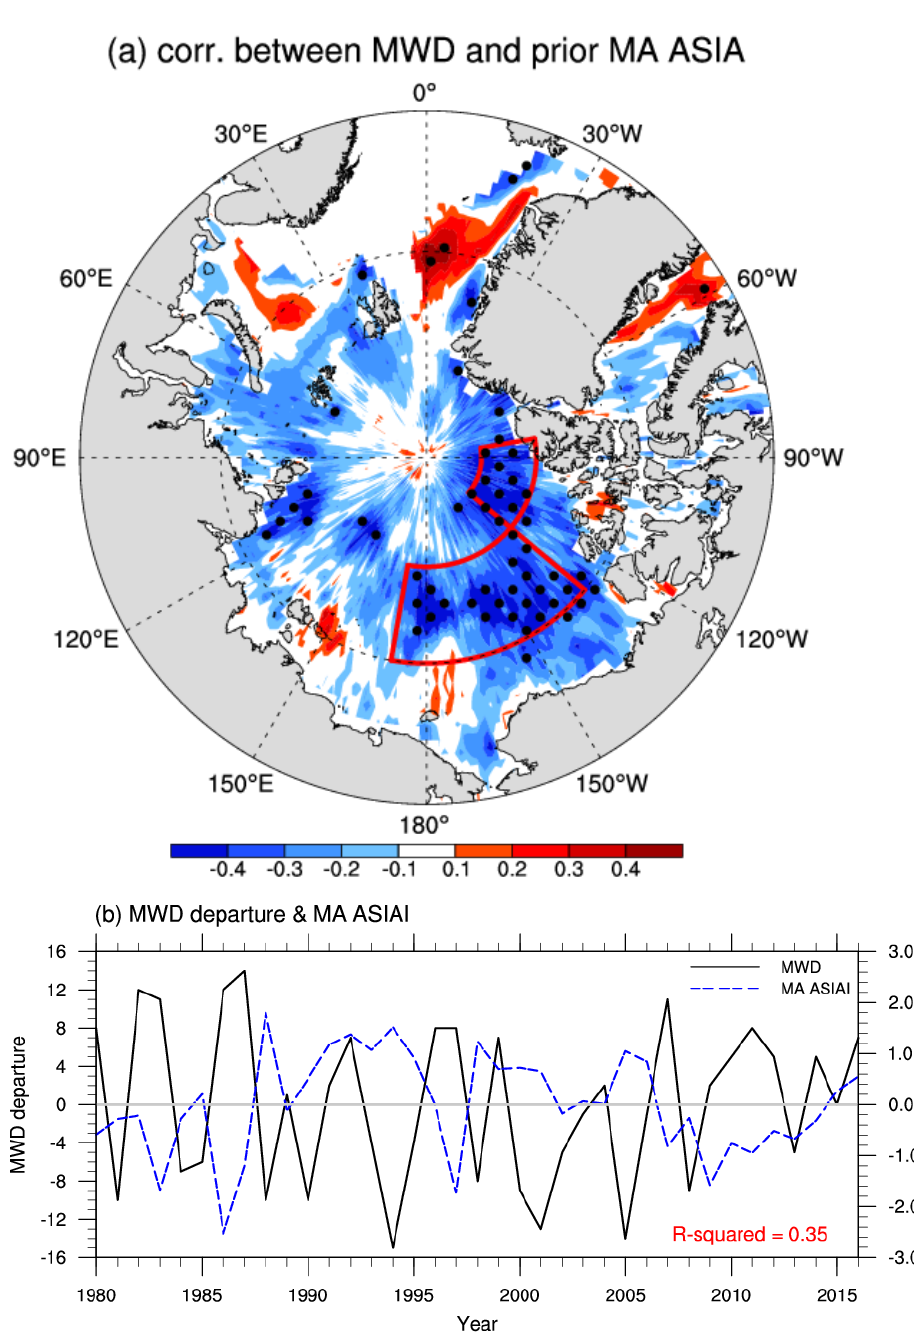
Figure 4. ( a ) Correlations between the MA–mean Arctic SIA and the MWD departure in the YHRB during 1980–2016. The two red frames in ( a ) outline the selected domains for calculating the Arctic SIA index (75° N–82° N, 170° E–130° W and 82° N–86° N, 130° W–80° W; the same hereinafter). Correlation coefficients significant at the 95% confidence level are dotted. ( b ) Time–series of the MWD departure in the YHRB (solid black line; unit: days) and the normalized MA–mean ASIAI (blue dashed line) in the period 1980–2016. The gray horizontal line for the MWD departure in ( b ) delineates the climatological–mean MWD (viz. 13 July). The numeral at the bottom (red) represents the determination coefficient (R–squared) between MWDs and the MA–mean ASIAI.